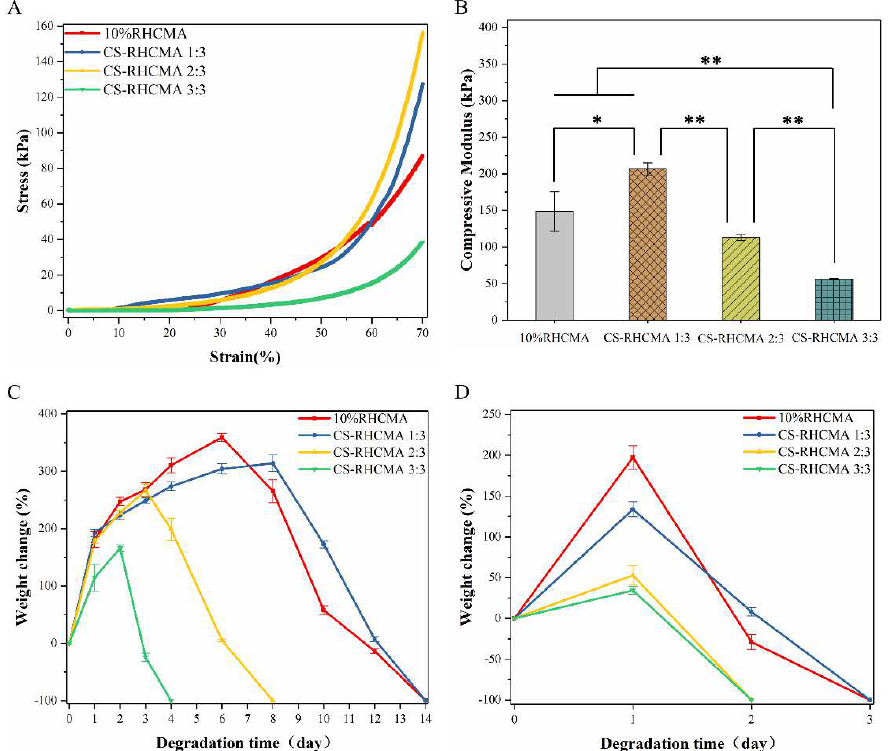
Figure 4. Characterizations of the samples prepared from UV-cured bioinks. ( A ) Representative stress-strain curves of RHCMA and CS-RHCMA samples. ( B ) Compressive modulus determined from RHC and CS-RHCMA samples, significance is indicated with * p < 0.05 and ** p < 0.01. ( C ) Degradation of RHCMA and CS-RHCMA samples incubated in PBS solution (pH 7.2). ( D ) Degradation of RHCMA and CS-RHCMA samples incubated in lysozyme solution (pH 6.5).